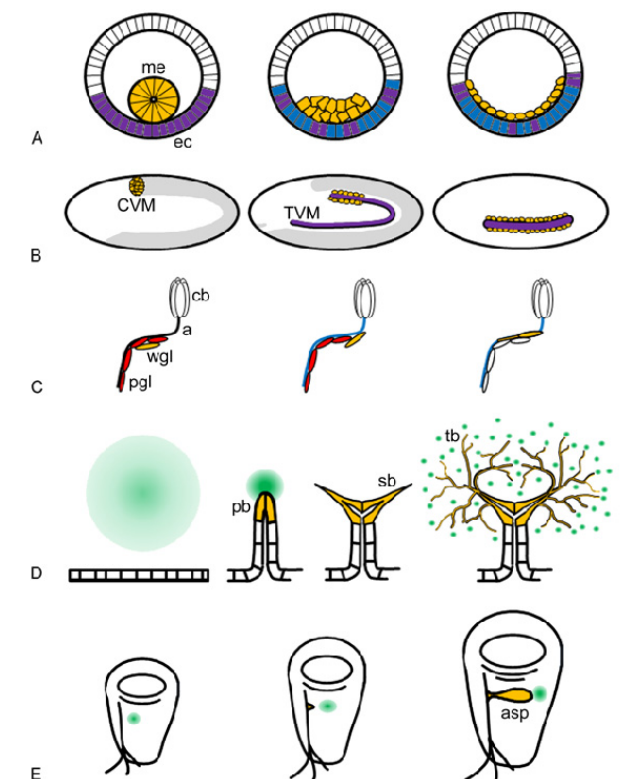
Figure 1. Developmental functions of FGF signalling in Drosophila . Diagram